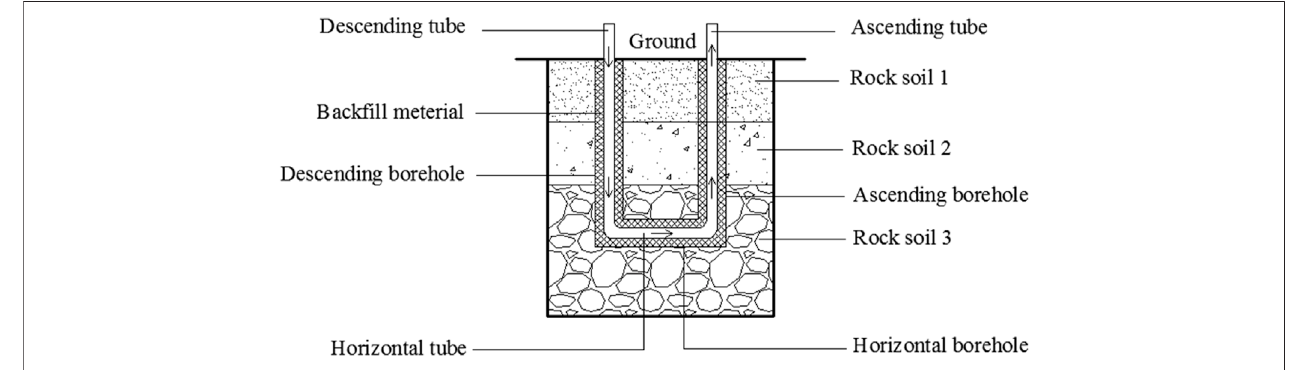
FIGURE 1 | Diagram of the U-type medium-deep